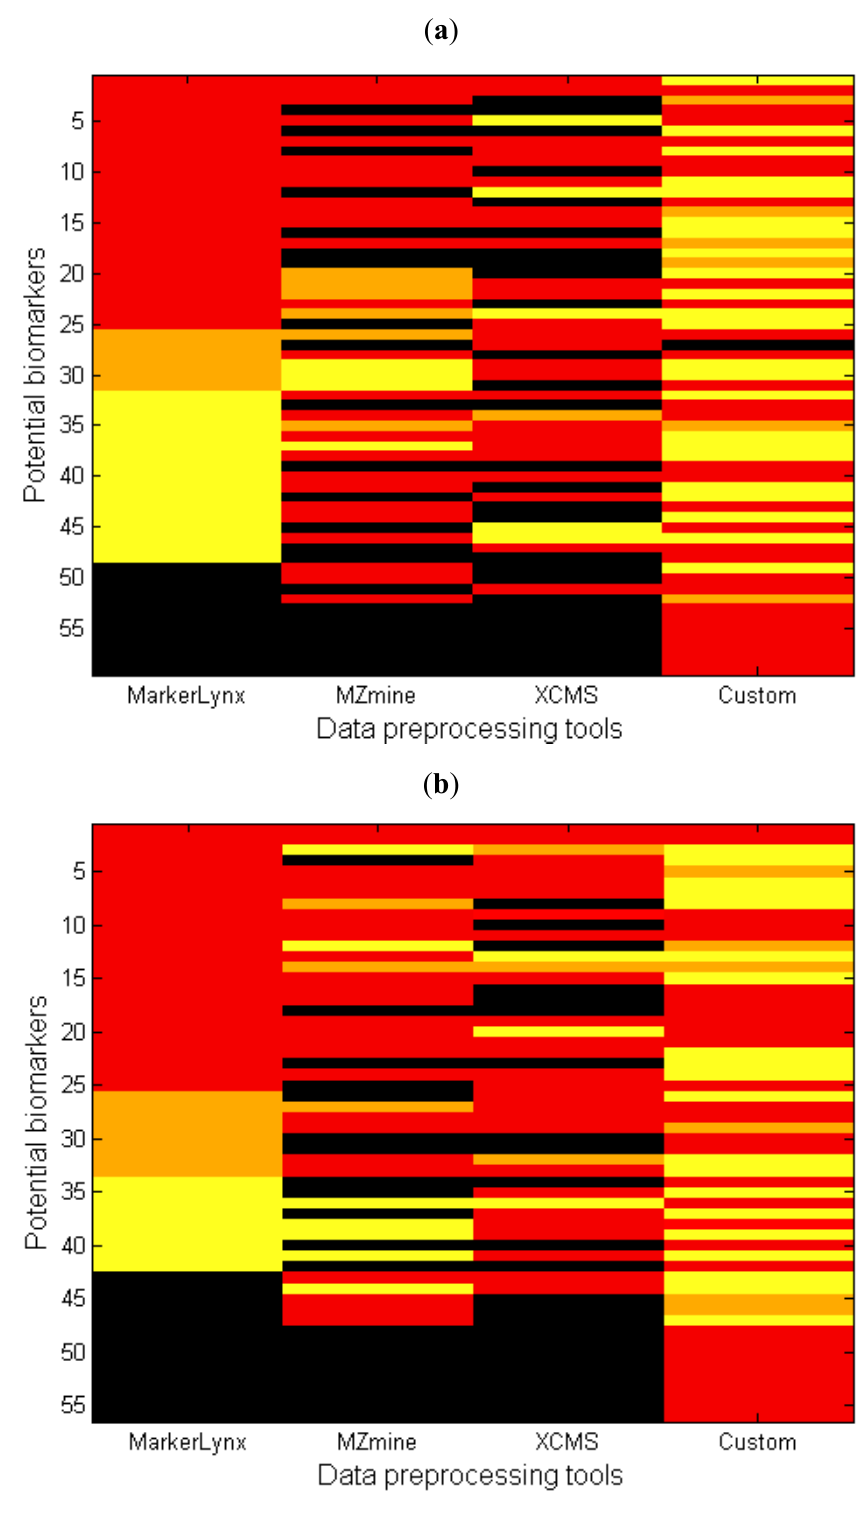
Figure 4. Heatmap comparing the importance of each marker based on four different data preprocessing tools for ( a ) negative and ( b ) positive mode data. Each row represents the lowest value rank of a metabolite for four different methods (Table 1, 3rd column). The markers were sorted in ascending order based on the rank obtained with